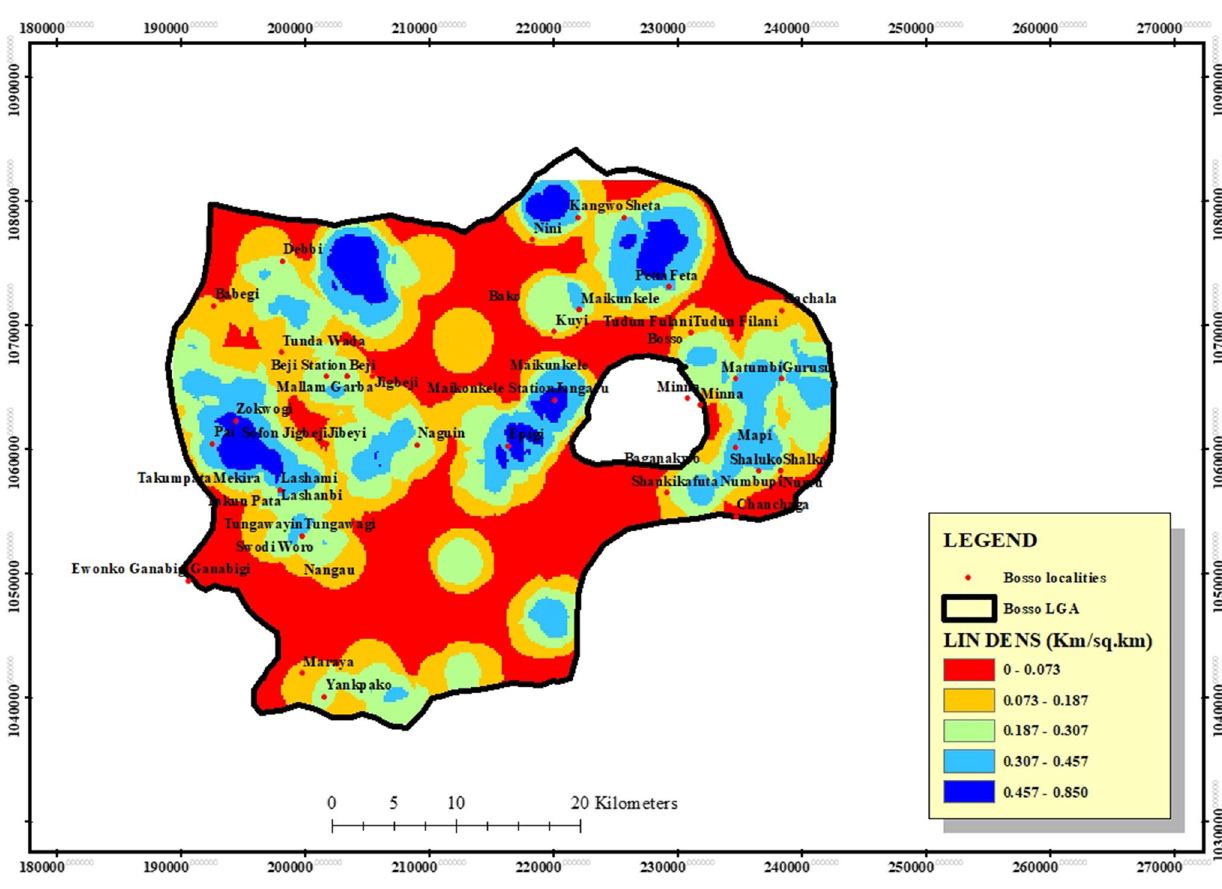
Fig. 5 Lineaments density